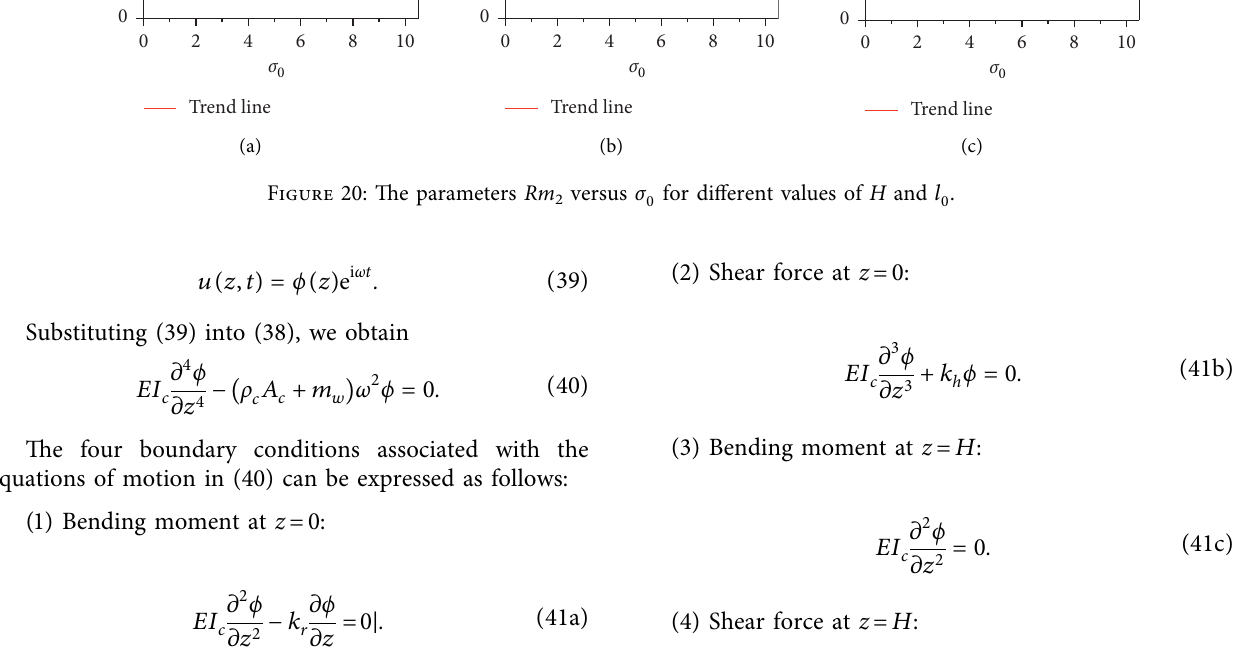
2 versus σ 0 for different values of H and